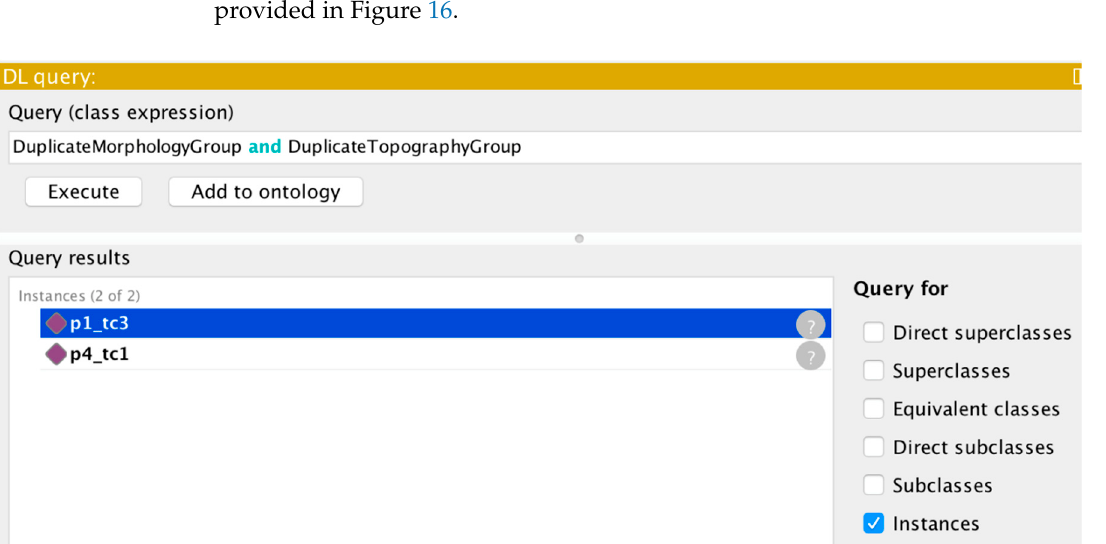
Figure 16. Explanation behind one of the results (p1_tc3) in Figure 15. In Figure 16, the reasoner has ascertained in lines 16 and 15 that there is only one morphology (i.e., the morphology codes are the same in both tumours of the tumour couplet). In lines 1, 13, 6, 7, and 3 the reasoner has ascertained that the conjunction of topographies C269 and C768 automatically triggers a duplicate topography group condition, c.f. Axiom (5). The final example in Figure 17 shows the results of a DL query on all entities having exactly one morphology. The reasoner has returned all the individual tumour cases (p1_t1–p5_t2) since these by definition have only one morphology and it has also returned the tumour couplet p1_tc3. This tumour couplet has two identical morphologies, c.f. Axiom (A1) in Appendix B and Figure 5.